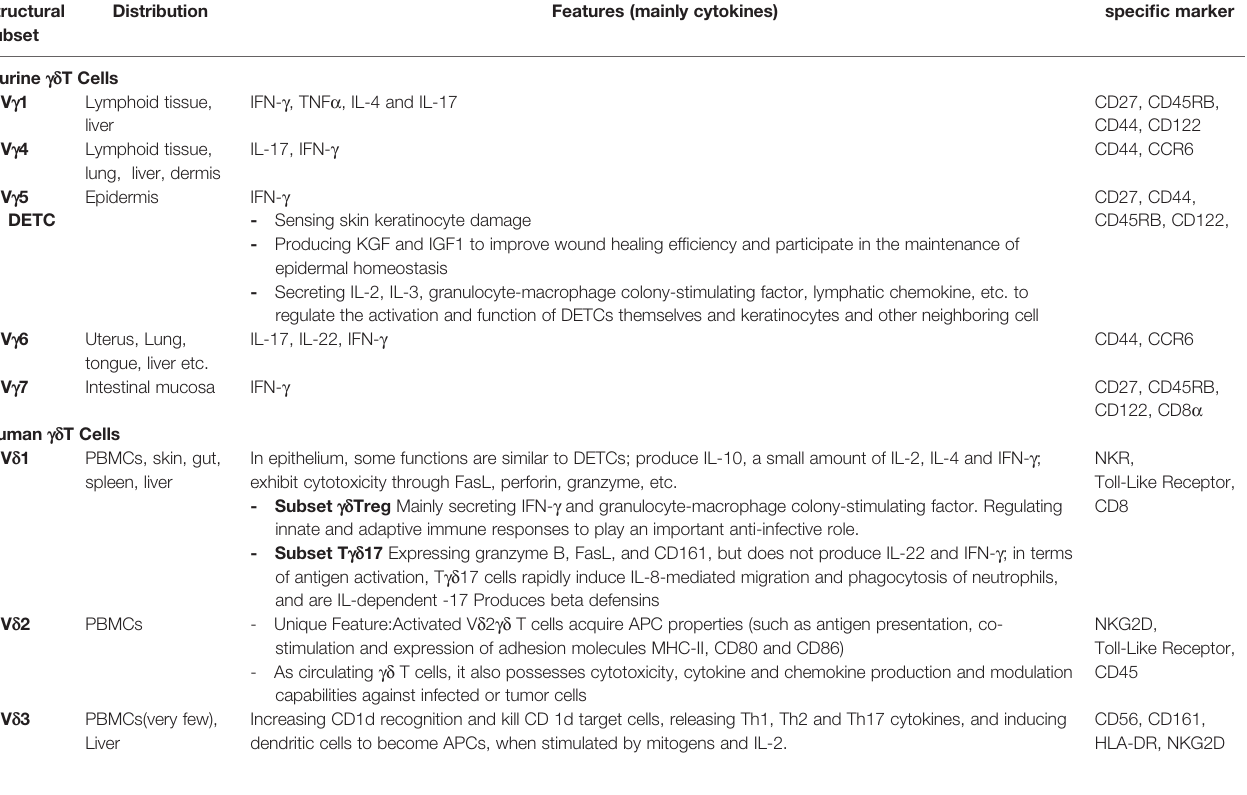
TABLE 1 | Distribution, features and speci fi c markers of distinct subsets of murine and human gd T cells. Structural